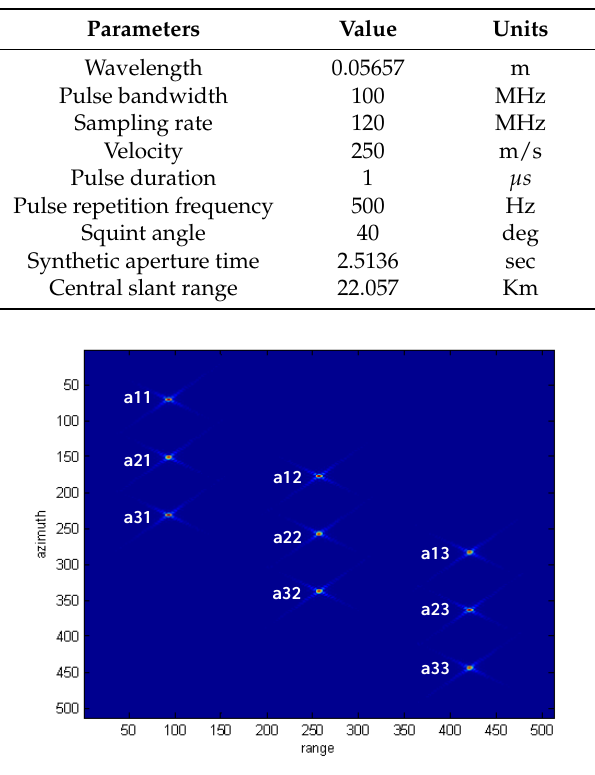
Figure 10. The squint SAR processed image using the proposed framework.